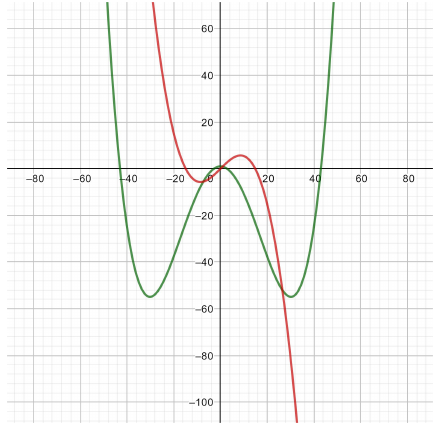
Figure 3. cos 2 ( x ) (green) and sin 2 ( x )